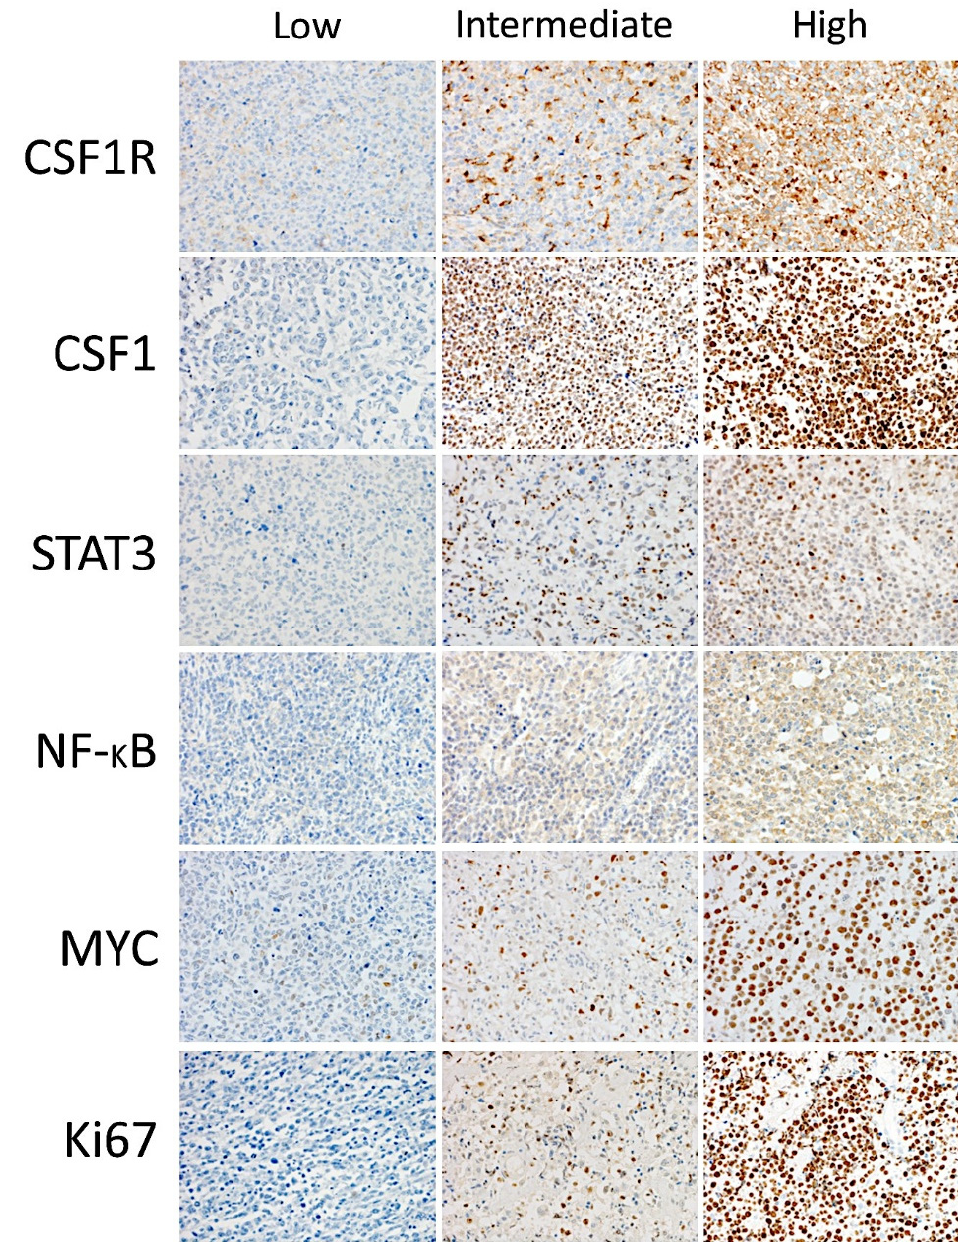
Figure 5. Immunohistochemical expression of CSF1R and some of the CSF1R-related markers. A logistic regression was performed to ascertain the effects of the most relevant genes, that were previously identified in the multilayer perceptron neural network analyses, on the likelihood that the patients have a high CSF1R expression. The genes with a normalized importance >70% were selected and the analysis included univariate and multivariate (backward conditional) tests. In the multivariate analysis, increasing expression of CD99P1, MVB12A, IKZF1 , and CEBPD was associated with an increased likelihood of exhibiting high CSF1R expression, but increasing PRH1 and C2orf74 was associated with a reduction in the likelihood of exhibiting high CSF1R expression (Table